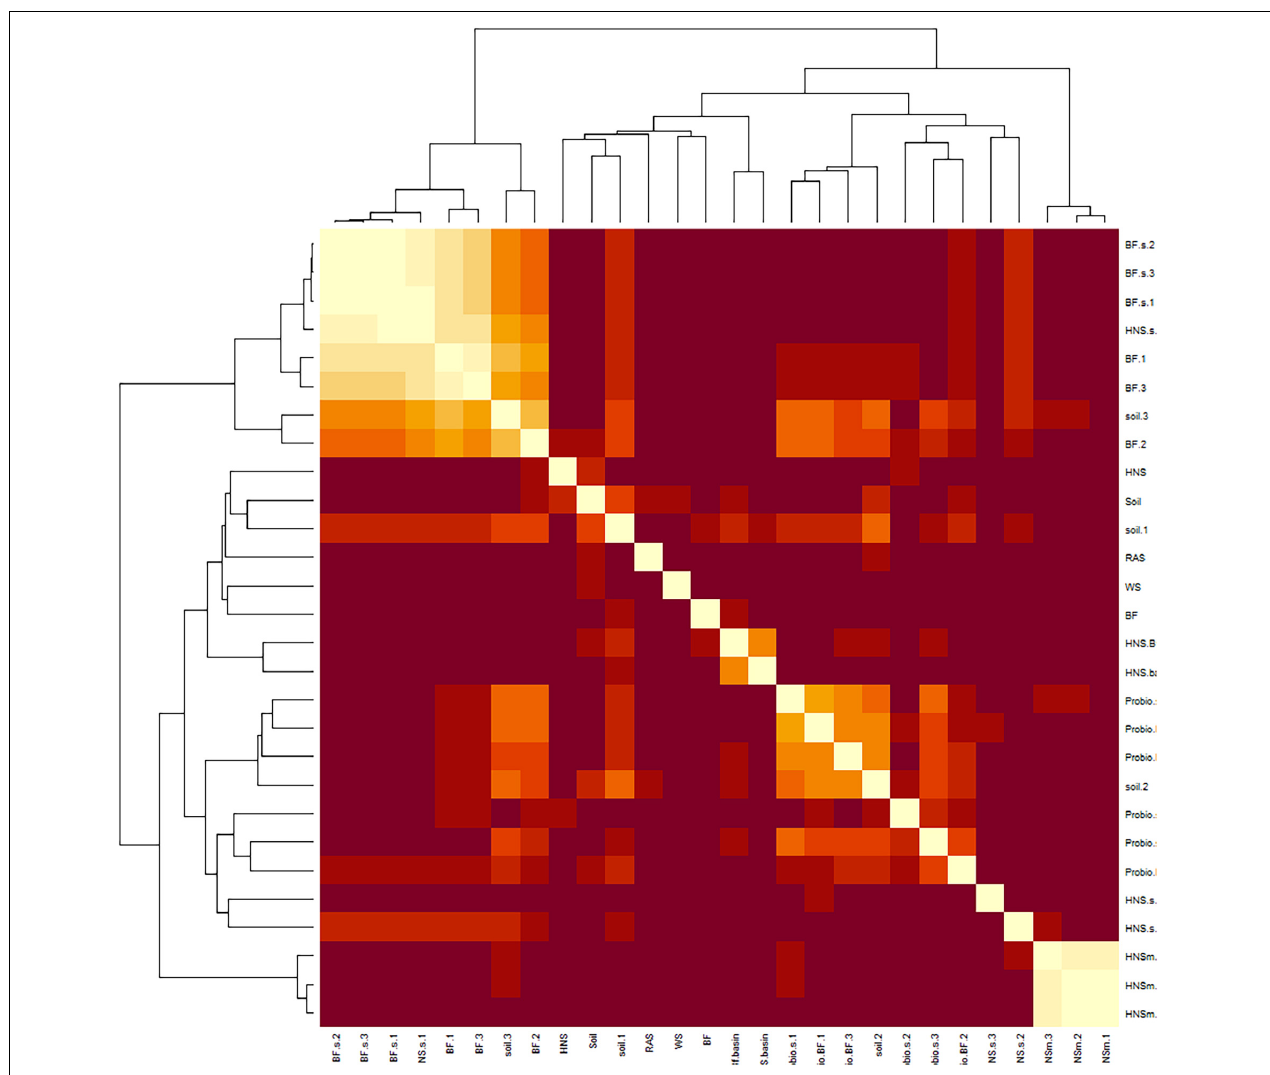
FIGURE 3 | Dissimilatory matrix between microbial communities of the treatments in the study at the genus rank. Similar patterns were observed at higher ranks. Treatments include hydroponic nutrient solution sump (HNS) and biofilter effluent sump (BF) under mature (.m), sterilized (.s), and basin water column (.aqueous) conditions. Additionally, soil inoculum (Soil) and HNS inoculated culture (soil) and probiotic (probio) inoculated sterilized (.s) and unsterilized biofilter effluent (BF) samples, as well as the facility water source (WS) and recirculating aquaculture system water column (RAS) are also included.